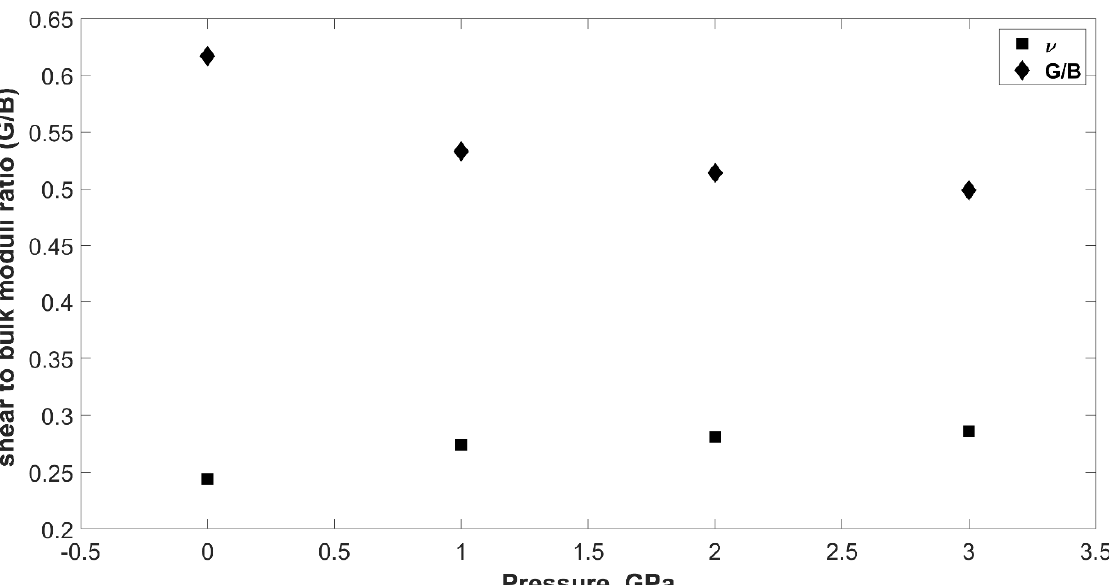
2 -NH sH gas hydrate at 0